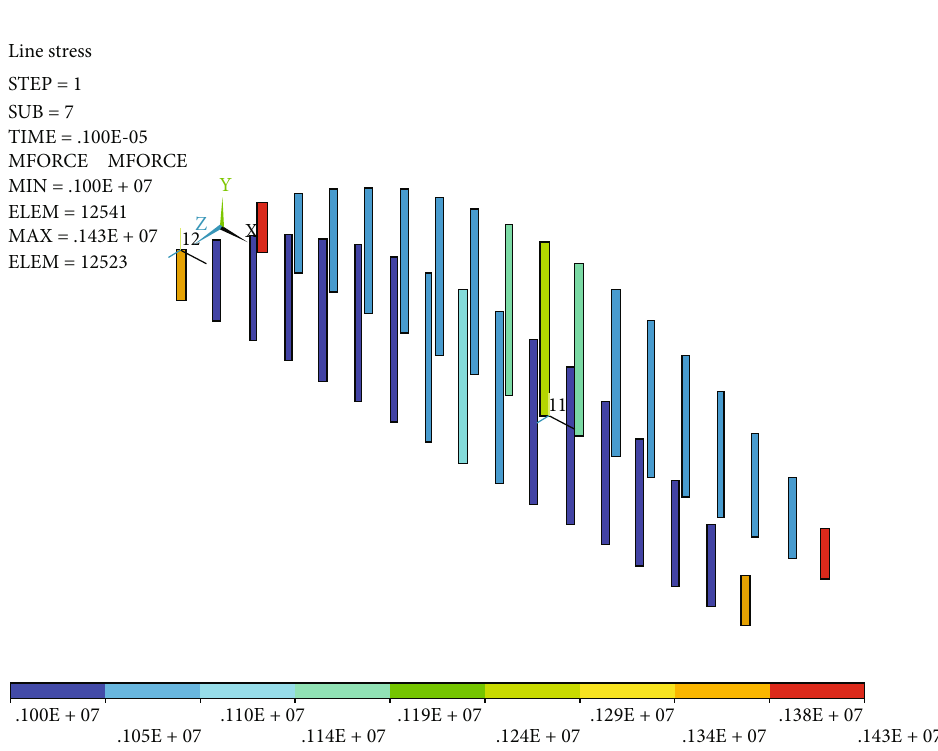
Figure 7: The axial force cloud map of hanger under case 2